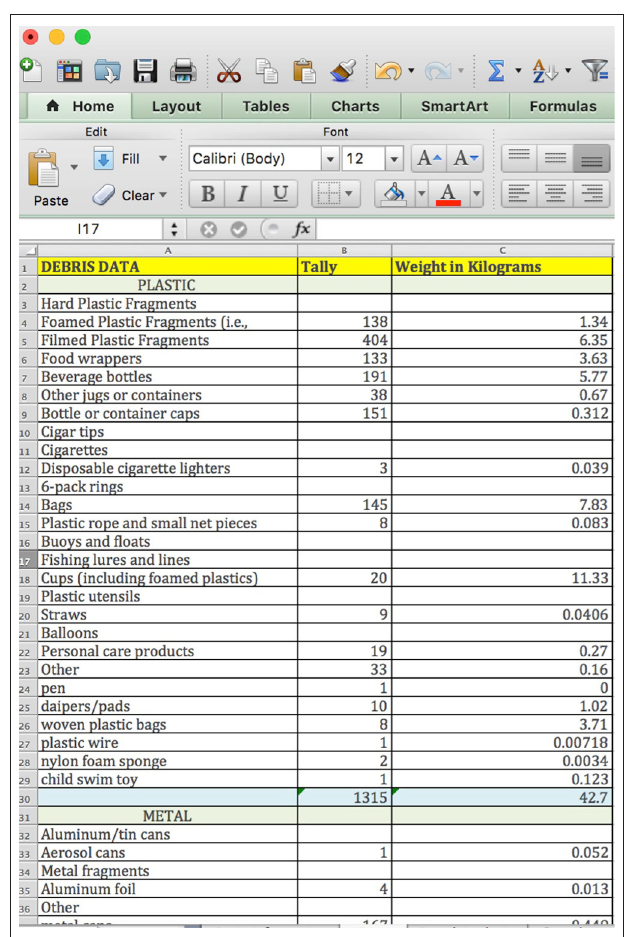
FIGURE 3 | Example data shown as entered into the spreadsheet after